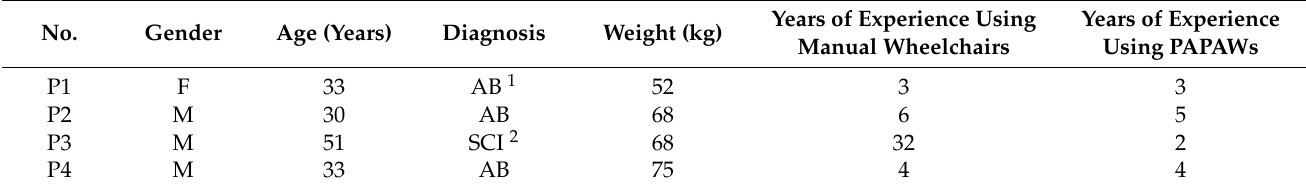
Table 3. Demographic information of study participants.